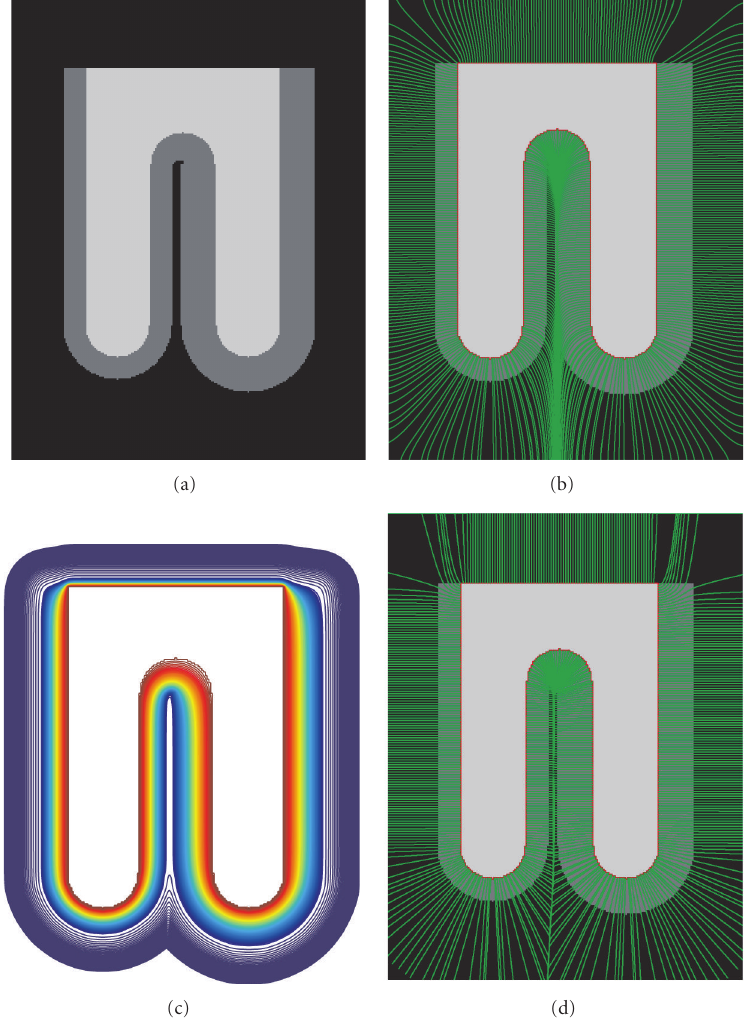
Figure 4: Cross-sections of simulated test images. (a) The input image; (b) field lines in the uniform permittivity model (Laplace equation). Bottom row: isocontours (c) and field lines (d) in the DELFMAP model with the dielectric layer (dark gray in the input